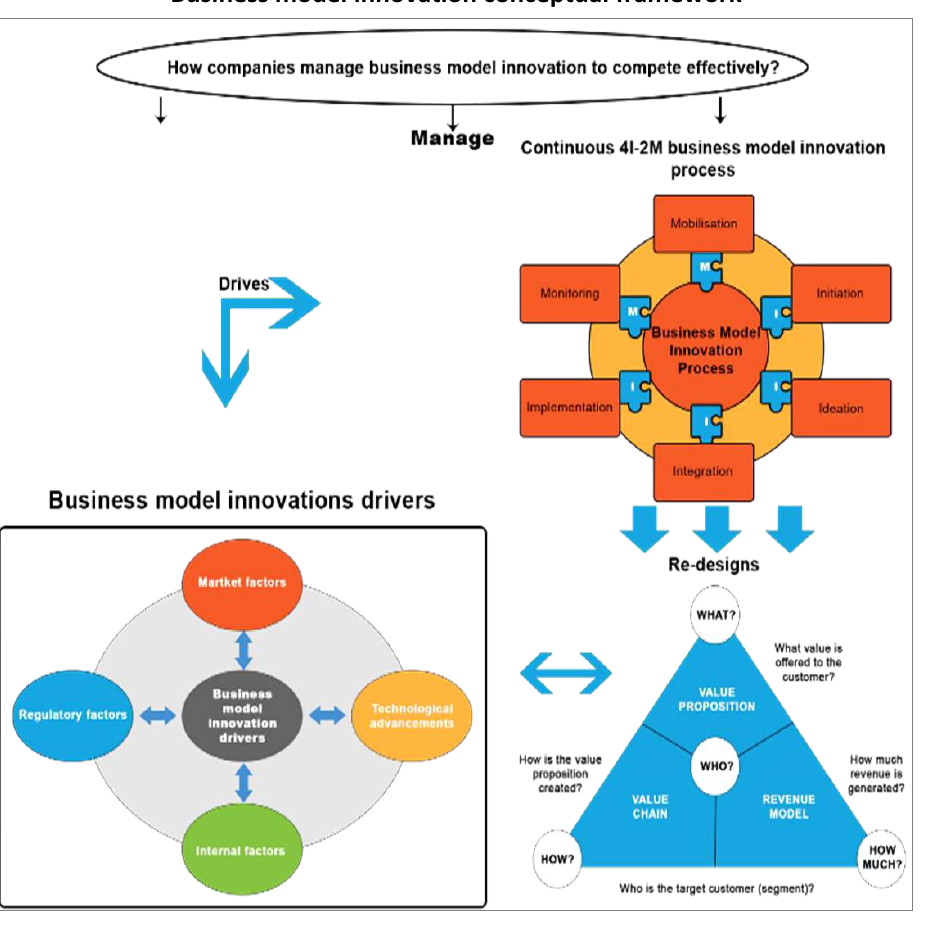
Figure 3. Conceptual framework three pronged approach business model